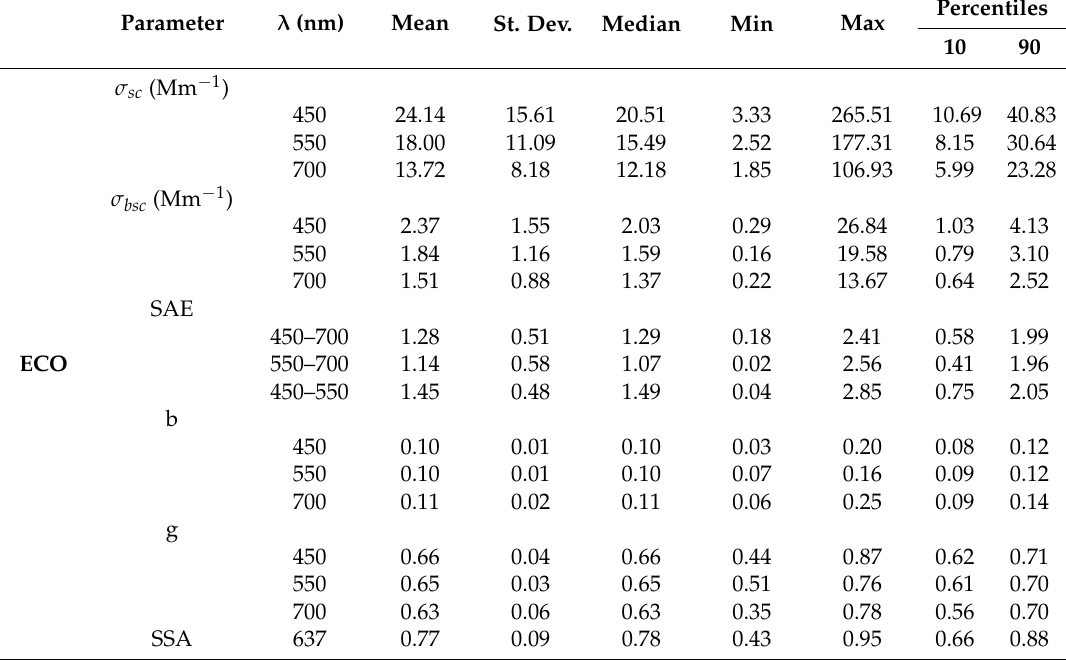
Table 3. Statistical properties (from 5 min average) of the measured and calculated optical properties over the whole period analysed for the ECO